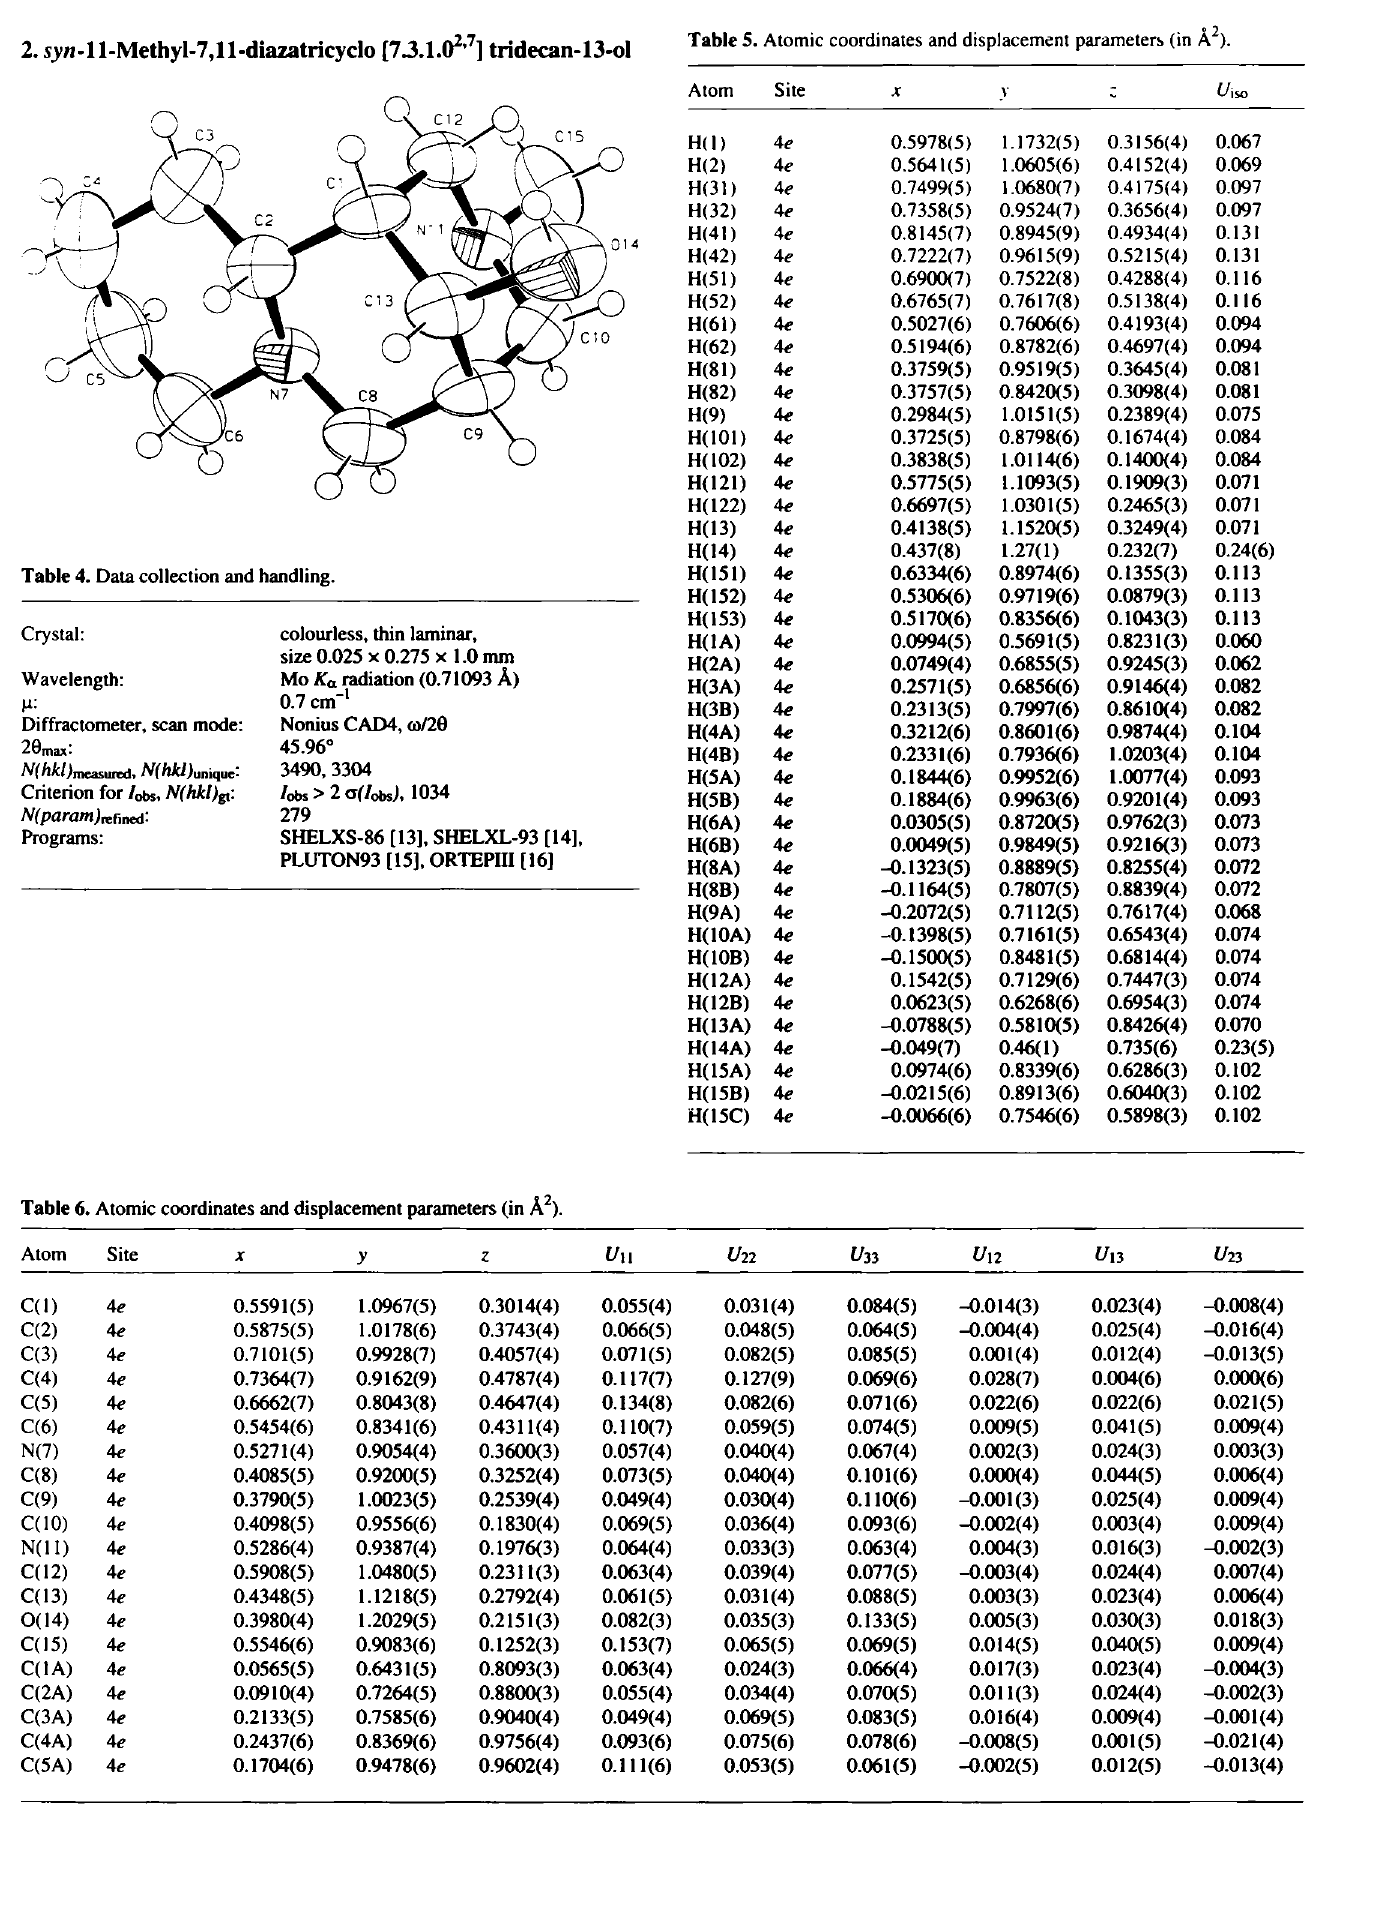
Table 4. Data collection and handling.